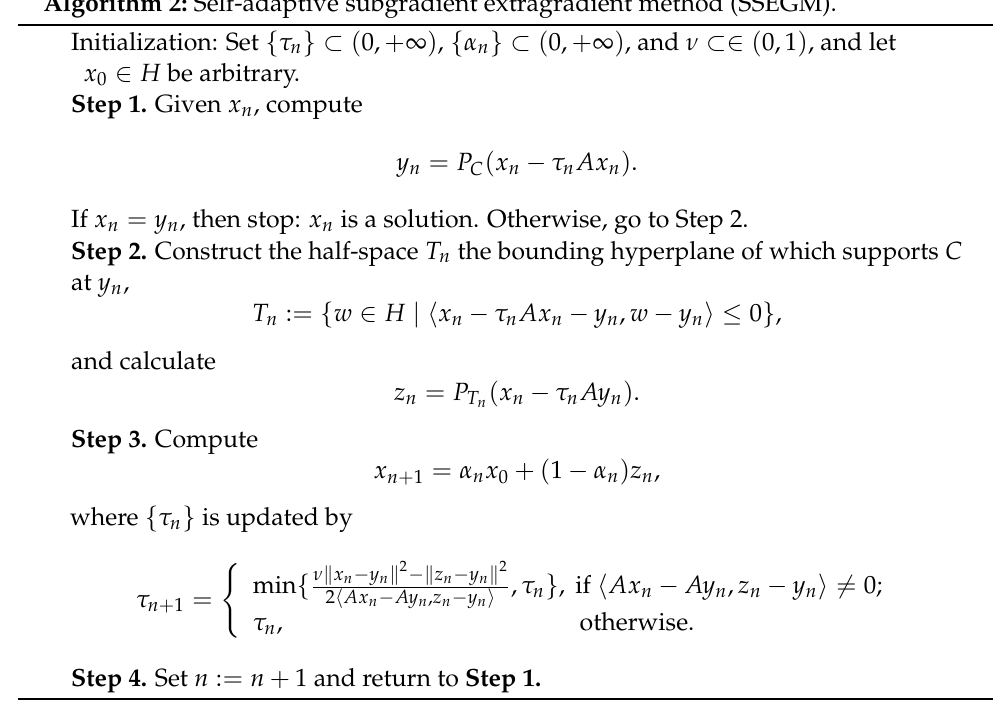
Algorithm 2: Self-adaptive subgradient extragradient method